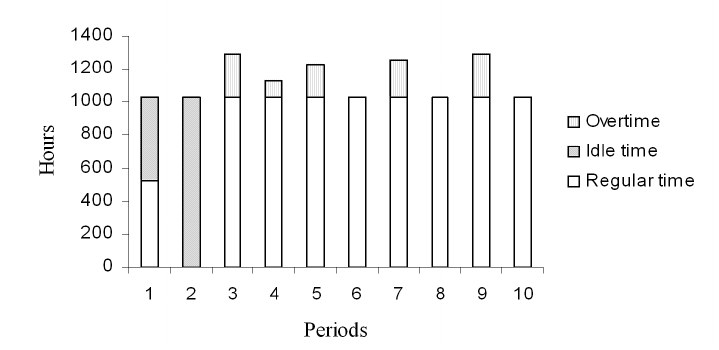
Figure 5: Comparison of total time, regular time, overtime and idle time that occurs in model